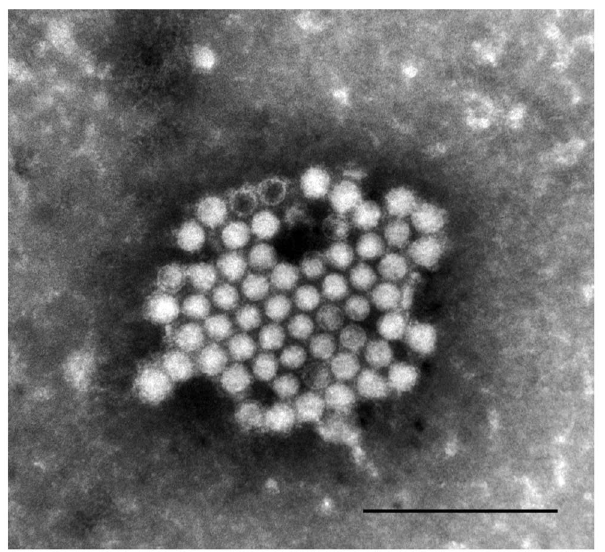
Figure 2. Electron micrograph of fathead minnow picornavirus. Negative contrast electron microphotograph of FHMPV-03 showing aggregation of non-enveloped spherical ( , 30–32 nm) virions consis- tent with virus of the Picornaviridae family. Bar=200 nm.